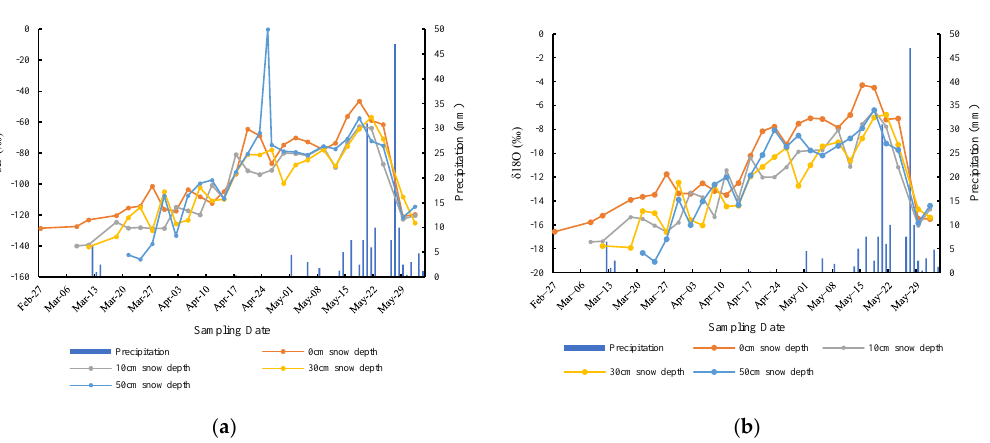
Figure 4. The change with time of δD and δ 18 O in soil water of different snow depth in 0 – 10 cm soil depth. ( a ) The change of δD ( b ) The change of δ 18 O.